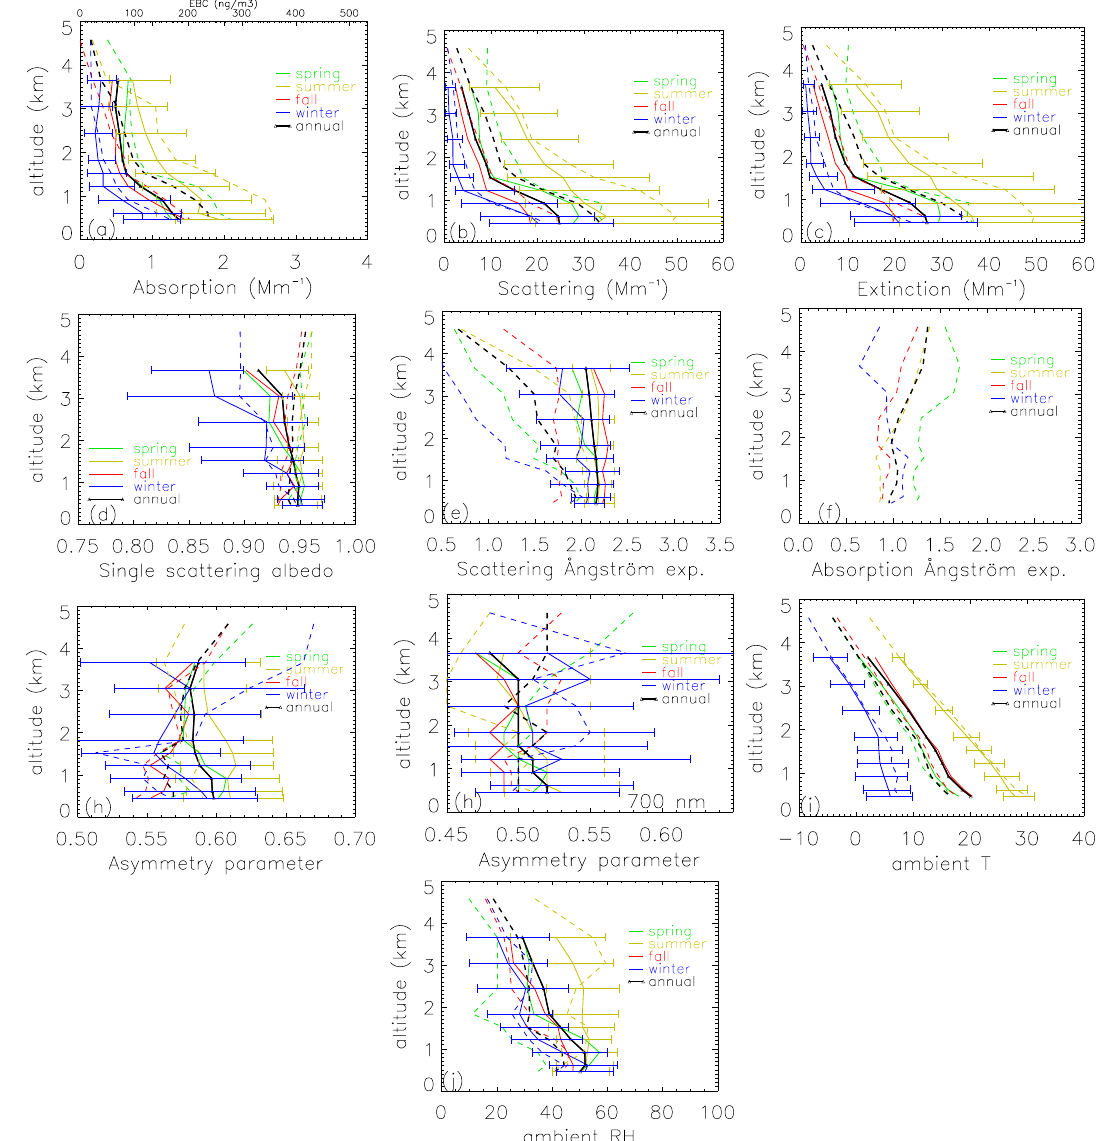
Fig. 2. Vertical profiles of aerosol optical properties and ambient T /RH. Solid lines are for March 2000–June 2005 time period (sub1-micron); dotted lines are for September 2005–Dececember 2007 time period (sub7-micron). Data are at RH < 40%, wavelength = 550nm unless otherwise noted (a) aerosol light absorption; (b) aerosol light scattering (c) aerosol light extinction (d) single scattering albedo (e) scattering ˚Angstr¨om exponent 550/700nm pair (f) absorption ˚Angstr¨om exponent 467/530/660 fit (g) asymmetry parameter (h) asymmetry parameter (700nm) (i) ambient T (j) ambient RH. Horizontal lines indicate 25th and 75th percentiles for winter (blue) and summer (gold) for sub- micron inlet data. Plots only include complete flights. Single scattering albedo, scattering and absorption ˚Angstr¨om exponents, sub-micron scattering fraction and asymmetry parameter were only calculated for scattering (550nm) > 1Mm − 1